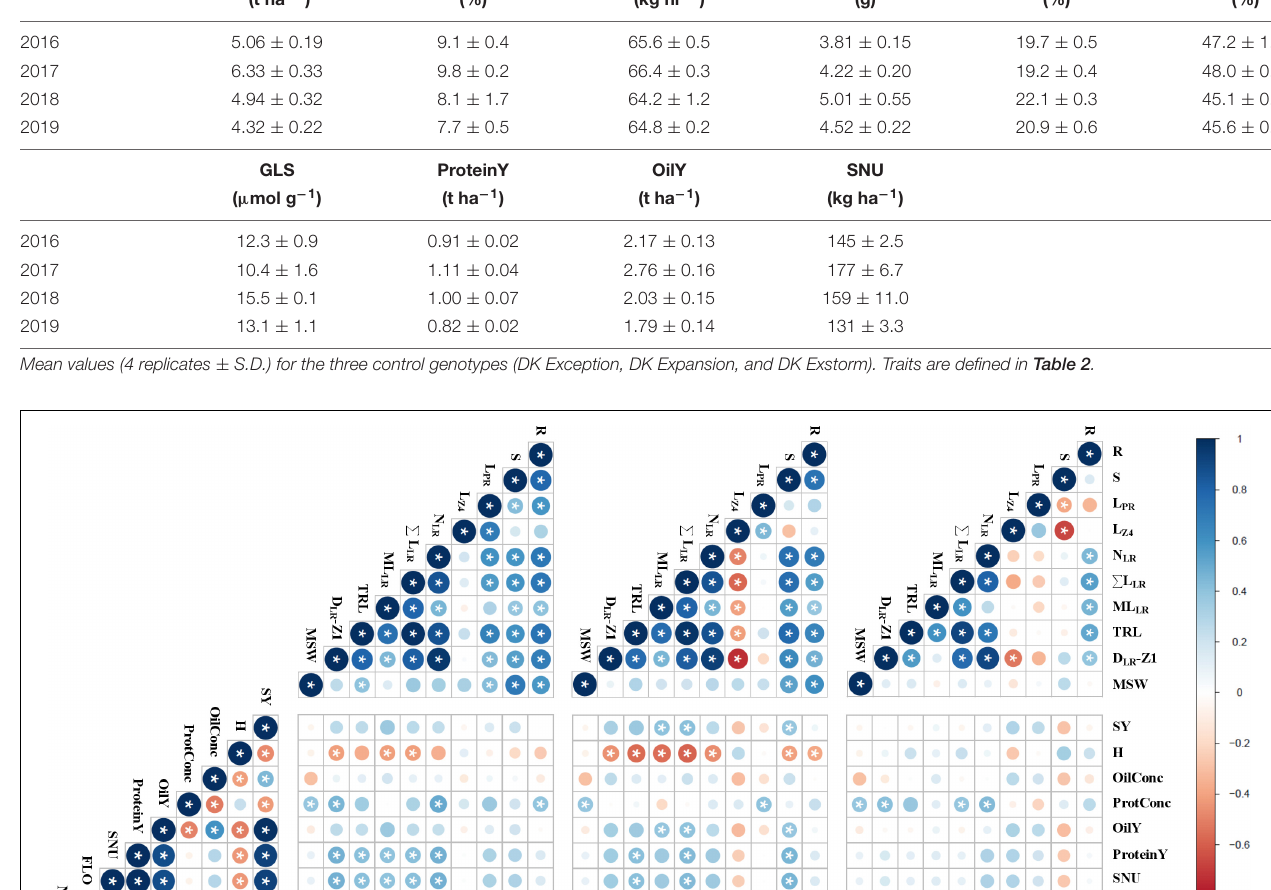
TABLE 4 | Seed yield and quality traits of the control cultivars for the four-year trial. Harvest Year SY H SW TSW ProtConc